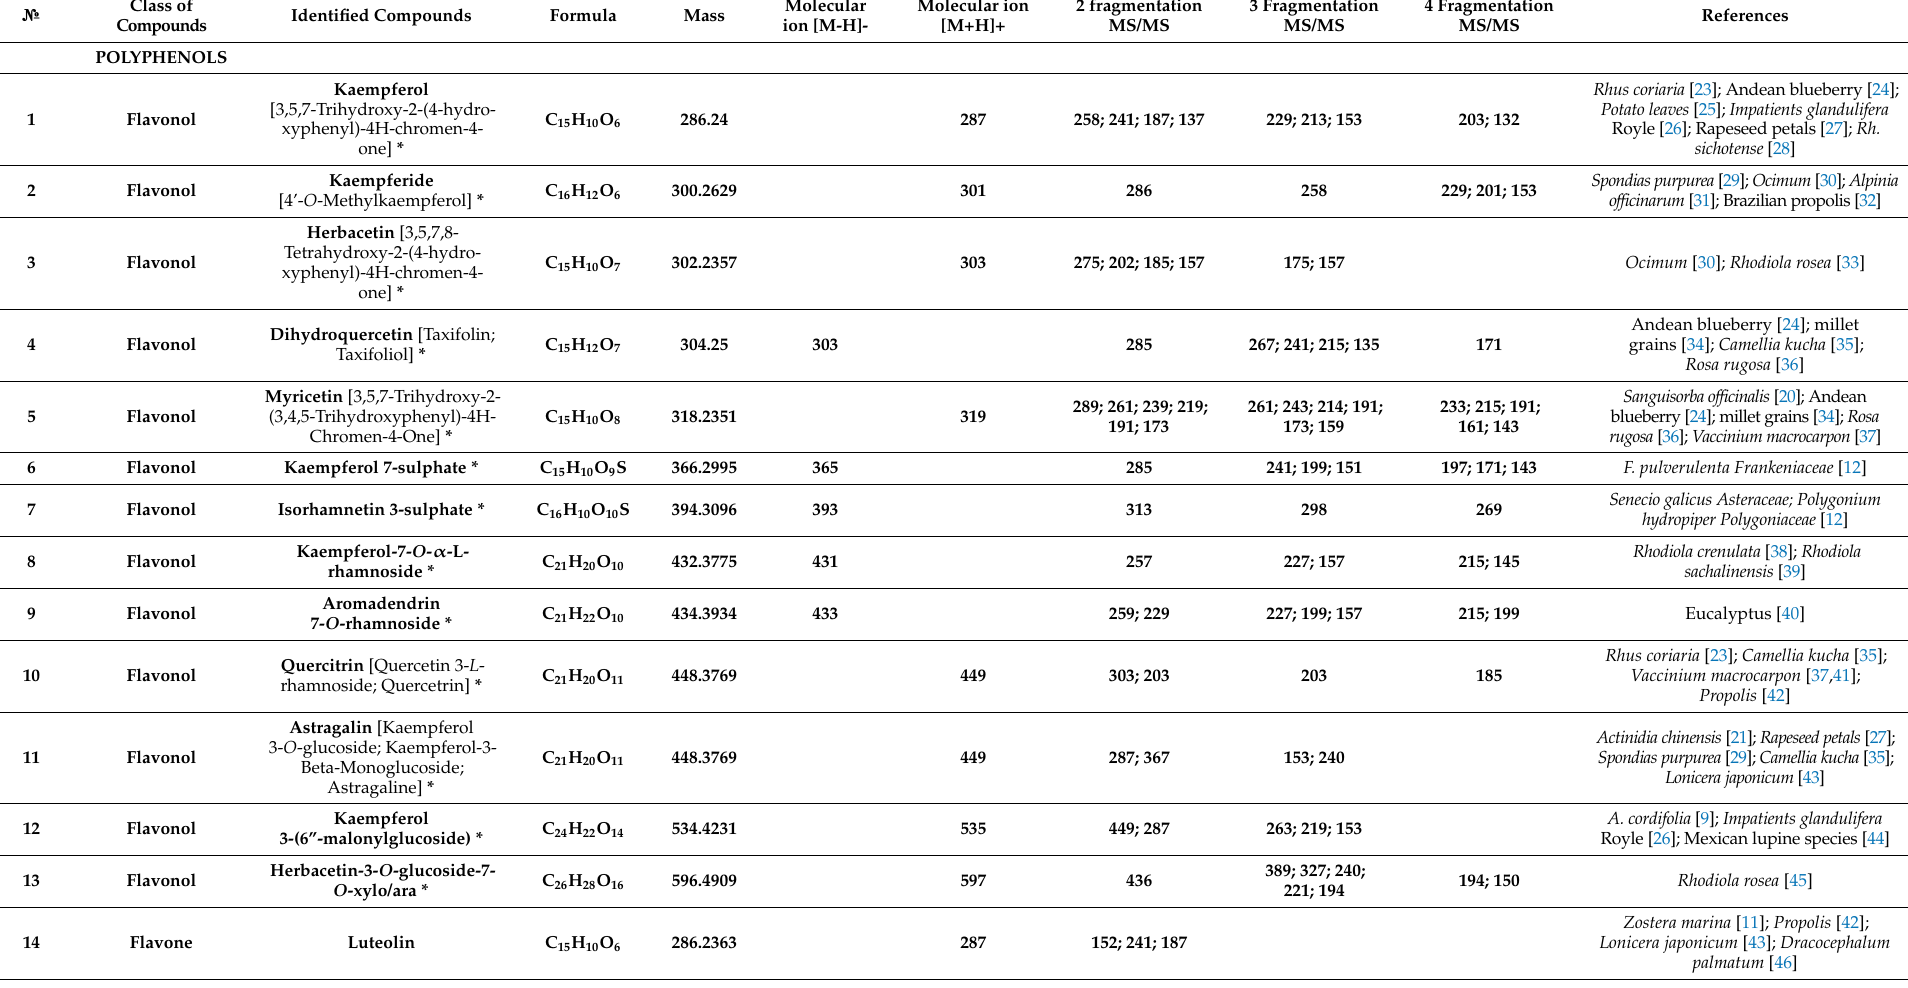
Table A1. Compounds identified from the CO 2 -extracts of Zostera marina in positive and negative ionization modes by HPLC-ion